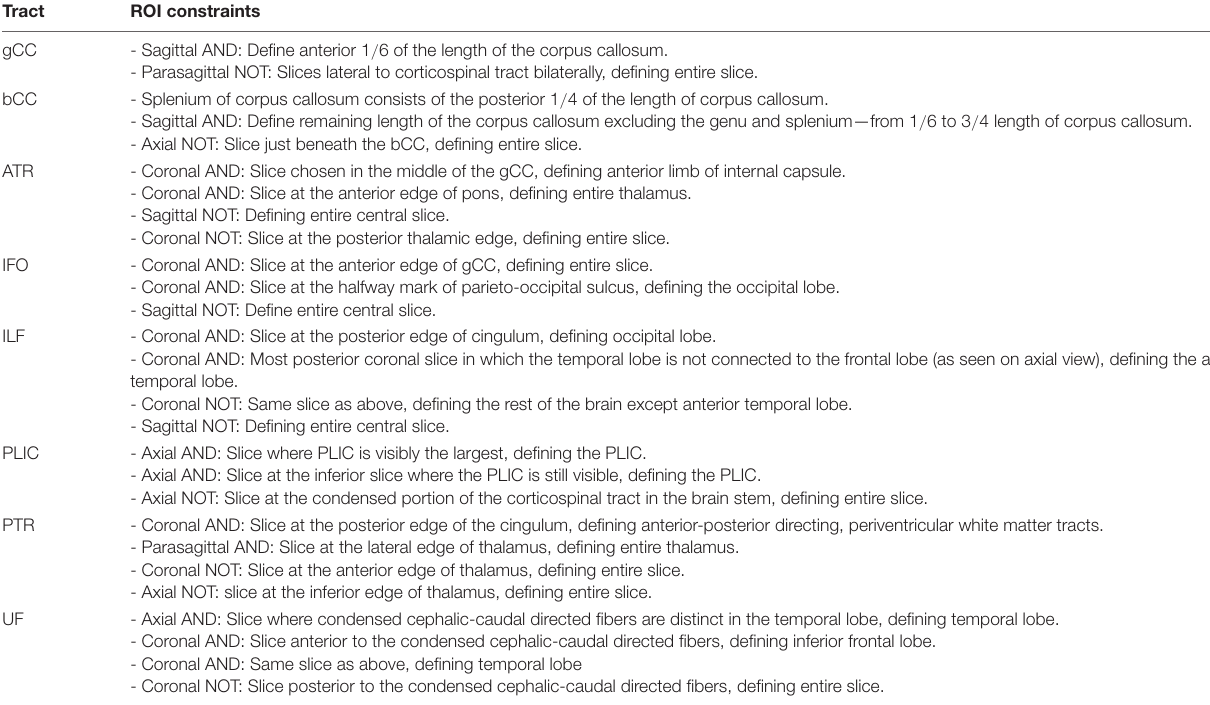
TABLE 1 | ROI constraints used to isolate white matter tracts in the pseudo-atlas for Method 1.